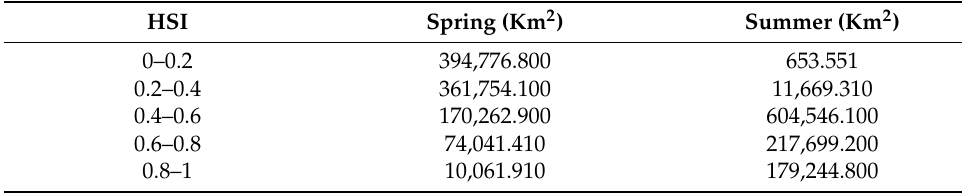
Table 6. Areas of different habitat types in spring and